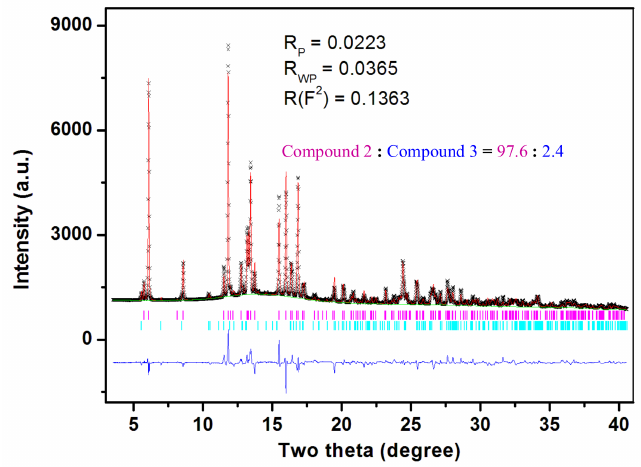
Figure 7. Representation of in situ synchrotron powder X-ray diffraction patterns of 1 during the phase transformations, indicating that compounds 2 and 3 were obtained in a ratio of 97.6% to 2.4%.